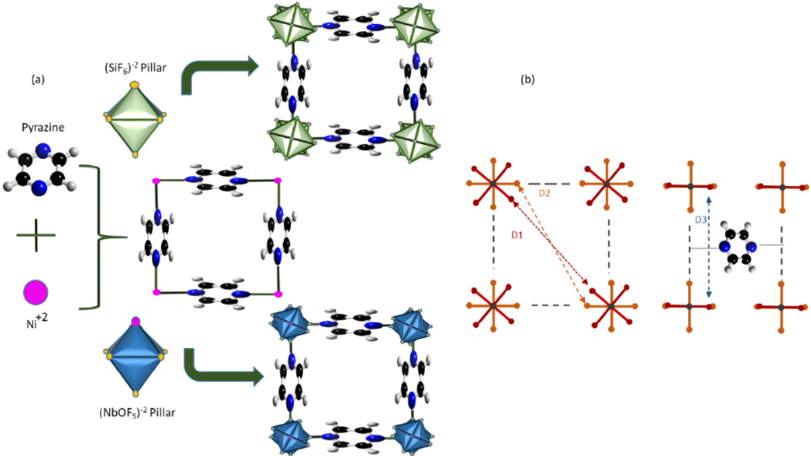
Figure 1. ( a ) Schematic of the basic structure of the pyrazine based metal organic frameworks used in the study. ( b ) Structural representation of the metal organic frameworks and size dimensions. Values of D1, D2 and D3 are given in Table 1 (dimensions are not to scale and for illustration pur- poses).